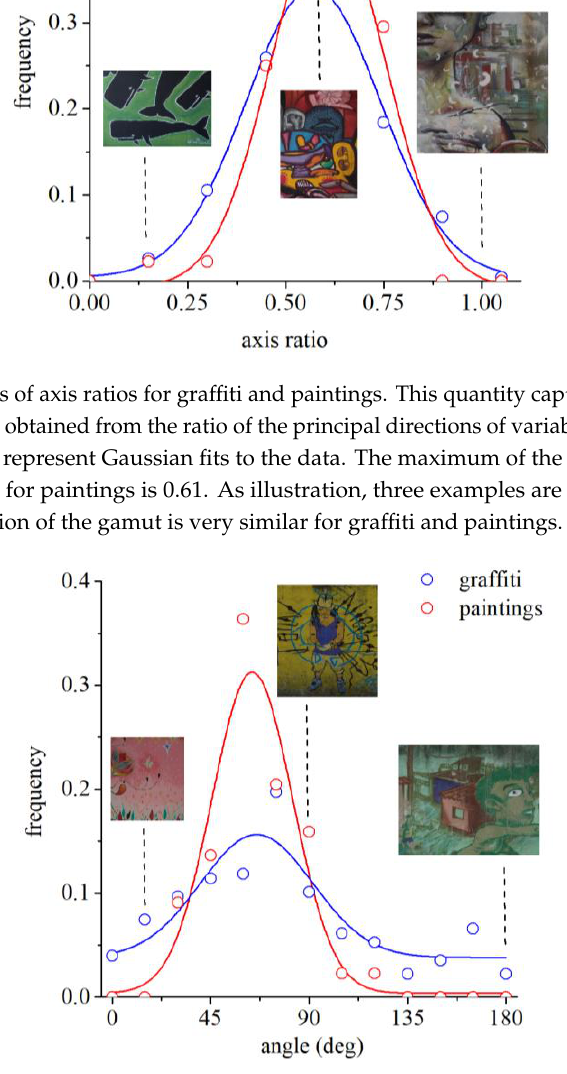
Figure 8. Distributions of the angle of the major axis (first principal direction) with the positive a* axis for graffiti and paintings. This quantity captures the type of colors that show greater variability. Circles represent data points, and lines represent Gaussian fits to the data. The maximum of the Gaussian distribution for graffiti is 66° and for paintings is 64°. As illustration, three examples are shown for the graffiti. The greater variability is in a yellow–blue direction of color space both for graffiti and paintings. The frequency of occurrence of each color was computed to compare the color distribution between paintings and gra ffi ti. For this analysis, the bin size was 1 unit in CIELAB, i.e., colors are the same if they are less than 1 unit apart. Figure 9 shows the results of this analysis: panels A and B show the contour lines of the frequency of occurrence of the colors in paintings and gra ffi ti, respectively; panels C and D represent the a* and b* histograms for paintings and gra ffi ti, respectively. These data show that the colors in gra ffi ti are used more isotopically than in paintings, i.e., the color distribution of gra ffi ti is consistent with the fact that the corresponding gamut orientations are more spread